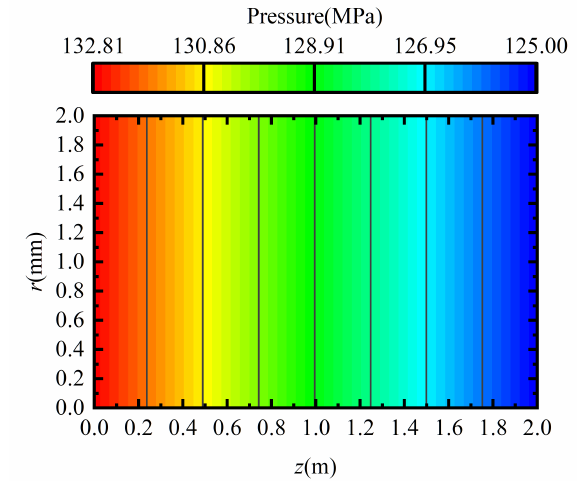
Figure 8. Pressure distribution with constant viscosity.